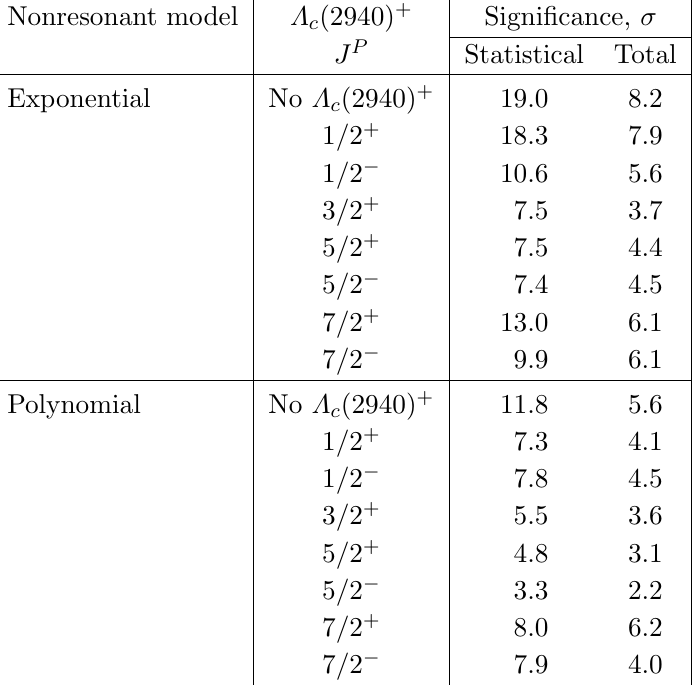
signments are excluded at the levels of 3 : 7, 4 : 4 and 4 : 5 standard deviations,